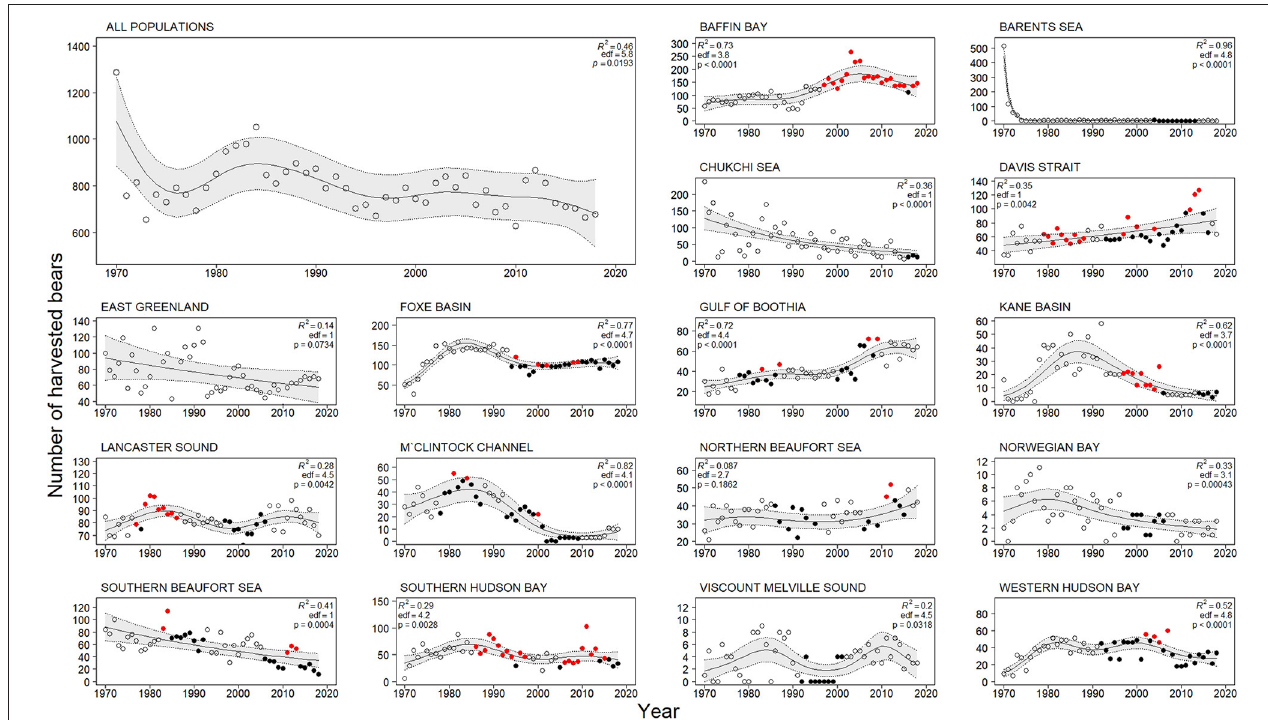
FIGURE 2 | Total annual harvest of polar bears summing all jurisdictions, except Russia (large panel top left), and annual harvest in 16 of 19 polar bear populations (small panels), in the period 1970–2018. No Russian data were available for Chukchi Sea and Barents Sea. Open circles represent years with populations estimates > 10 years old, black circles years with population estimate ≤ 10 years and harvest rate ≤ 4.5%, and red circles represent years with population estimate ≤ 10 years and harvest rate > 4.5%. Trend lines are fitted with a Generalized Additive Model (GAM, k = 6). Gray bands indicate the 95% confidence intervals.